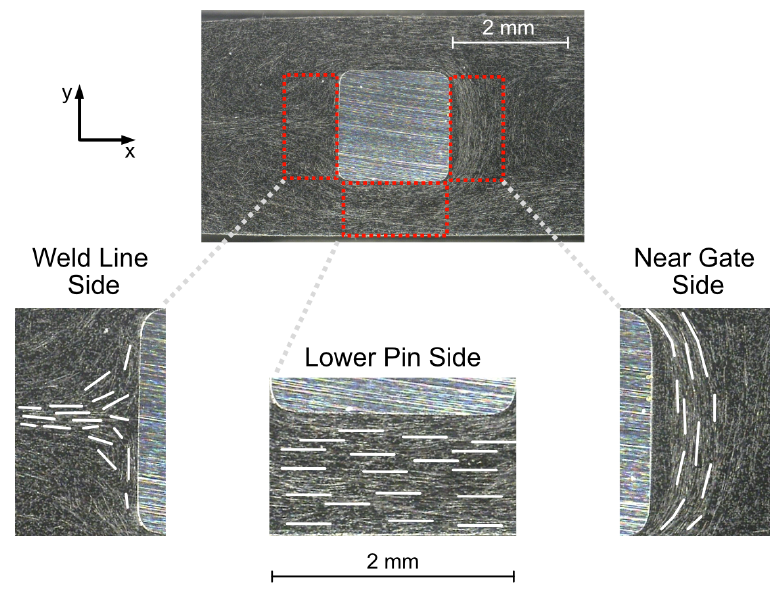
Figure 15. Pin sides according to a PC CF20_4 mm sample including indications for significant orientations.